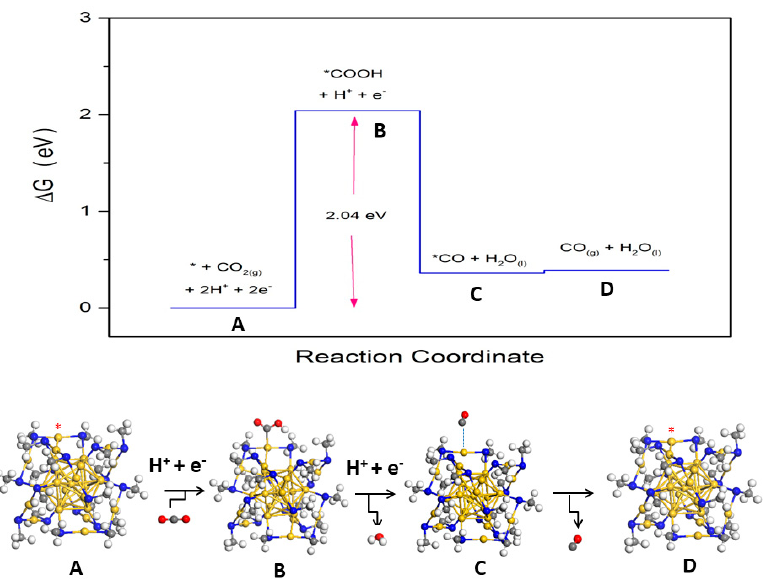
Figure 3. Free energy profile of the CO 2 reduction to CO in the intact Au 25 (SCH 3 ) 18 − nanocluster. Adapted from Reference [52]. Copyright by The American Institure of Physics (2016).